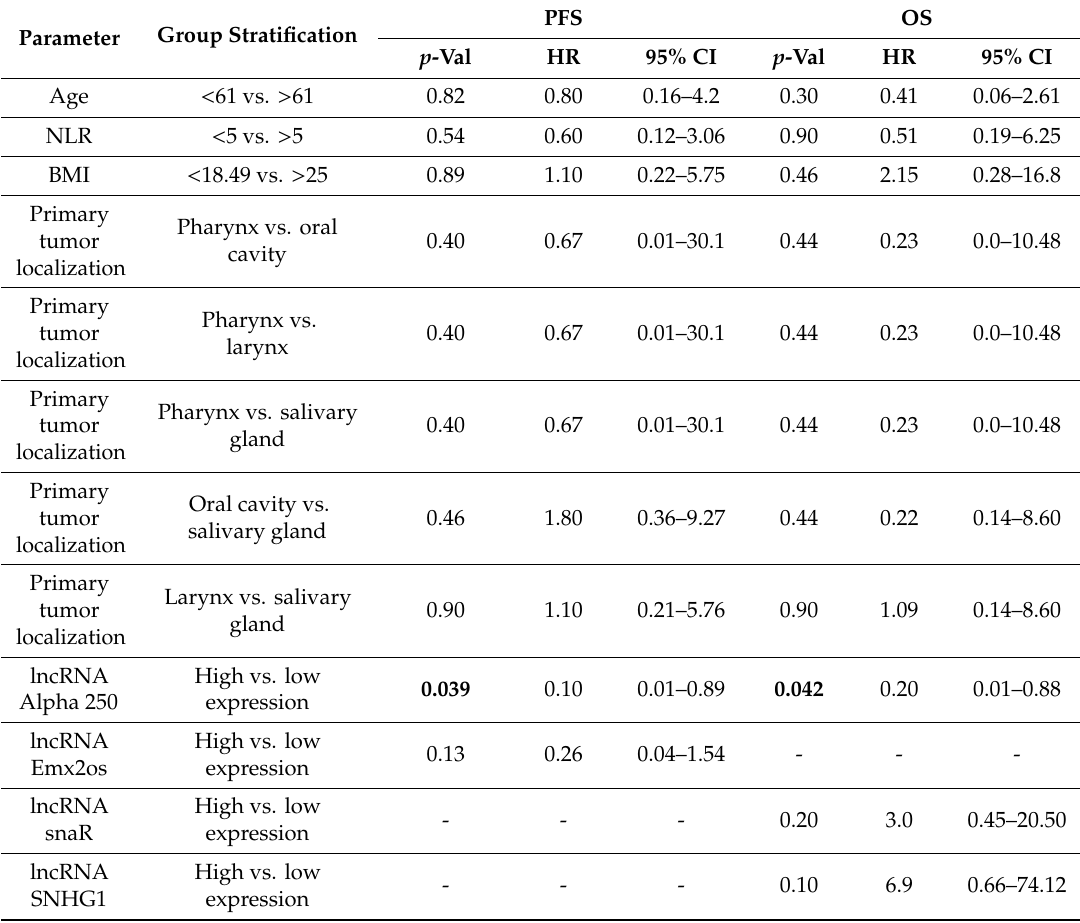
Table 1. Univariate Cox regression model for PFS and OS. PFS—progression free survival; OS—overall lymphocyte